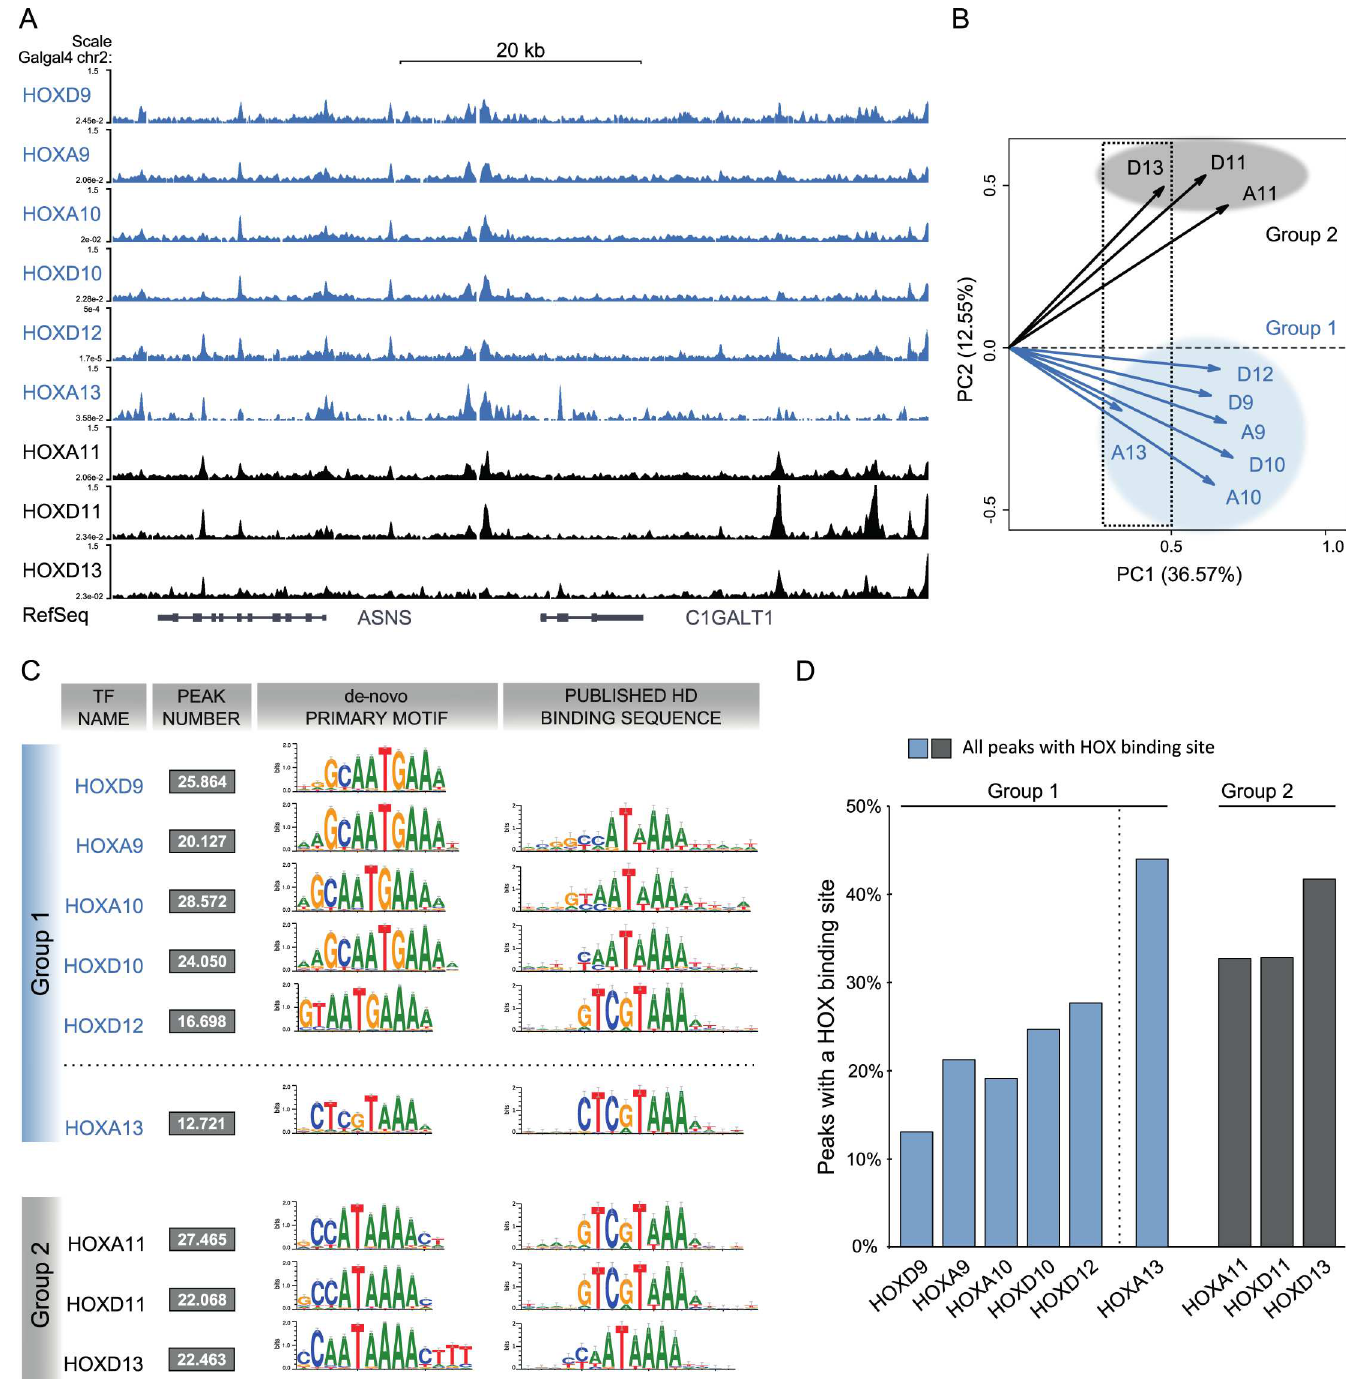
Fig 2. Genome-wide binding profiles of posterior HOX-TFs revealstwo groups of binding. (A) ChIP-seq profiles of nine posterior HOX-TFs (Group 1 –blue, Group 2 –black). (B) PrincipalComponentAnalysis (PCA) analysisof HOX-TF peaks. HOX13 paralogscluster separate on PC1 (dotted rectangle). PC2 revealstwo distinct groups of HOX-TFs, Group 1 (blue) and Group 2 (black). (C) De novo motif analysisfor the HOX-TFs. Primary motifs obtained from the top 5,000 peaks in comparisonto the previously identifiedmotifs for their respective homeodomains (Berger et al., 2008). Group 1 sequence preferences(except HOXA13, dashed line) are distinct from Group 2. See S1B Fig for additional HOX-like motifs identifiedin the Top 5,000 peaks. (D) Quantificationof peaks carryingbindingsites (sequences matchingany of the top 3 HOX-TF motifs; FIMO p value (cid:20) 0.0001). Each peak carrying a sequencematch is countedonly once. Bindingsite count in top 1,000 and top 10,000peaks are shown in S1C Fig.